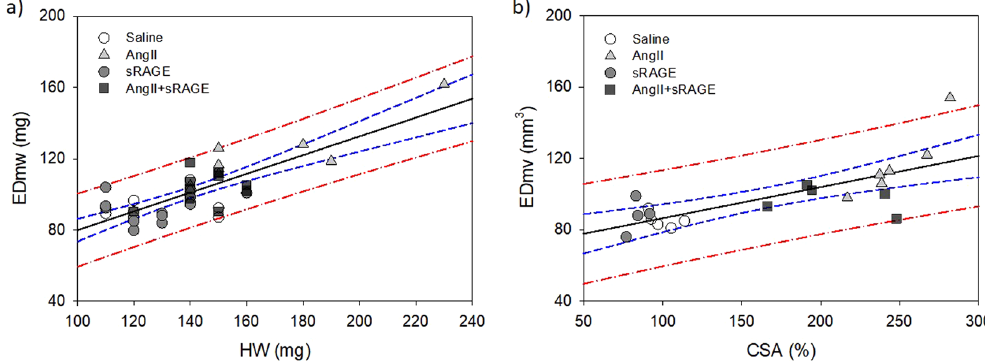
Figure 6. Linear regression analysis between CINE-MRI and histological data. ( a ) Linear regression between EDmw and HW (R 2 = 0.63, p < 0.0001), ( b ) between EDmv and CSA (R 2 = 0.54, p = 0.0002). Black straight line: Regression line, blue dashed line: 95% confidence band, red dot-dashed line: 95% prediction